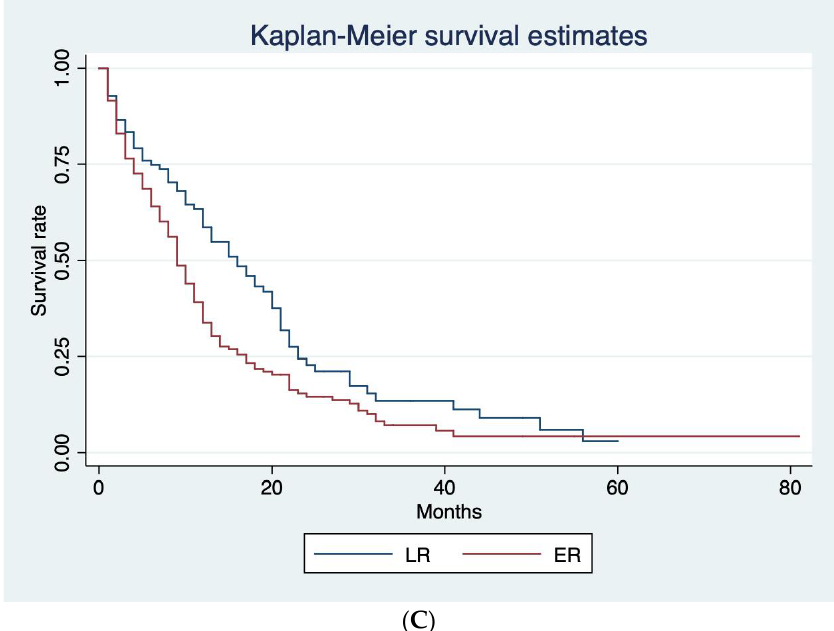
Figure 2. Kaplan–Meier survival curves for ER and LR, according to the different cut-offs. ( A ) Post- progression survival (PPS) curves for ER and LR adopting 6-months cut-off. ( B ) Post-progression survival (PPS) curves for ER and LR adopting 8-months cut-off. ( C ) Post-progression survival (PPS) curves for ER and LR adopting 12-months cut-off.